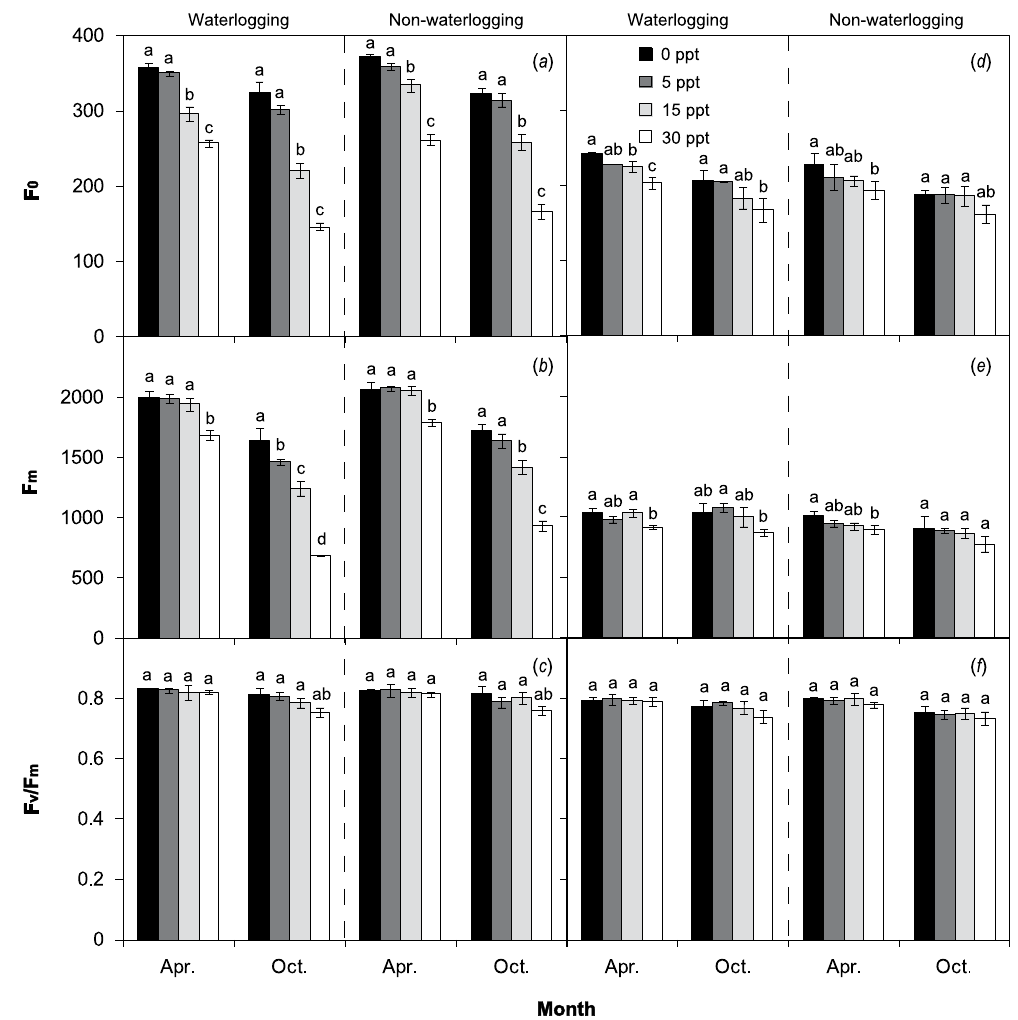
Figure 4. Minimum chlorophyll fluorescence of the open photosystem II center (F 0 , mean ± S.D.), maximal chlorophyll fluorescence of the closed photosystem II center (F m , mean ± S.D.), and maximum (dark-adapted) photochemical efficiency of photosystem II (F v /F m , mean ± S.D.) of P. australis ( a – c ) and S. alterniflora ( d – f ) under waterlogging (separated by a dashed line) and salinity treatments in the early and late growing seasons. Different letters indicate significant differences ( P < 0.05) among salinity treatments for each measurement